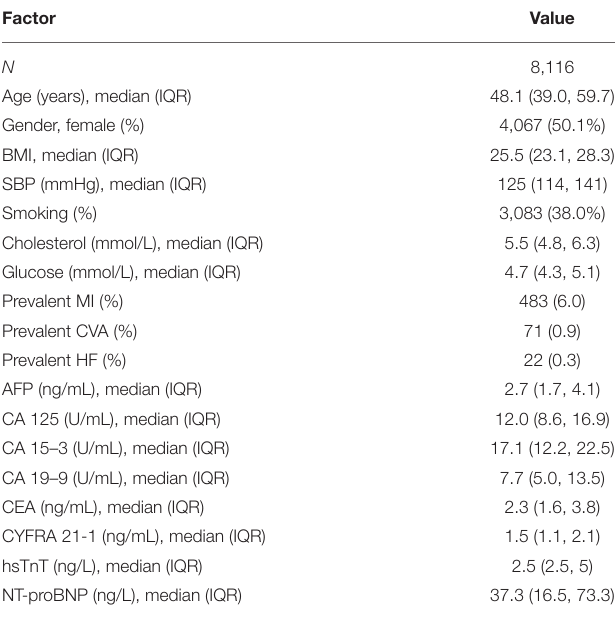
TABLE 1 | Baseline characteristics of study population.